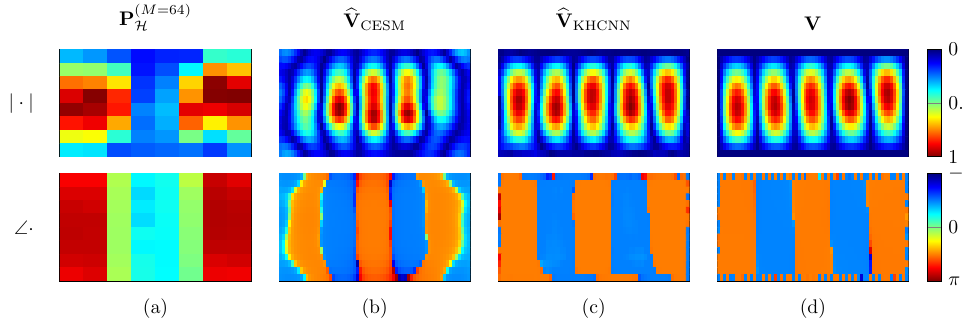
Figure 9. Reconstruction example of CESM and KHCNN for a simply supported rectangular plate with dimension [ L x , L y , L z ] = [ 0.32,0.17,0.002 ] m vibrating at 1371Hz. The first and the second row depict magnitude and phase of the complex fields, respectively. Column ( a ) is the input pressure at the hologram in M = 64 points. The CESM and KHCNN velocity estimate are depicted in column ( b ) and ( c ), respectively. Column ( d ) shows the velocity ground truth coming from